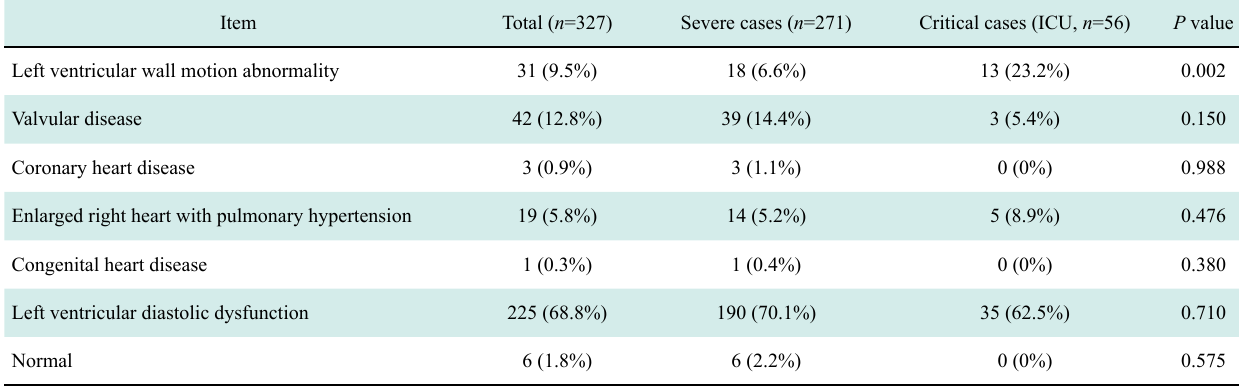
Table 3 Bedside echocardiography findings of COVID-19 confirmed